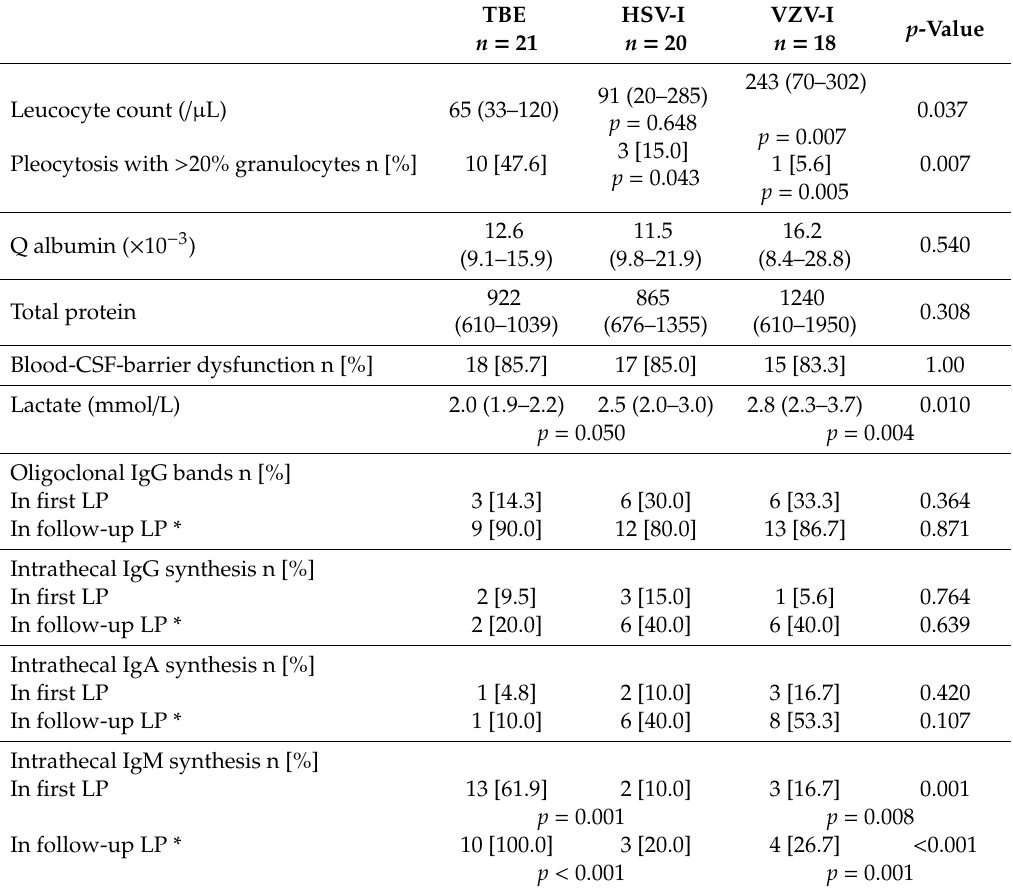
Table 2. Cerebrospinal fluid (CSF)